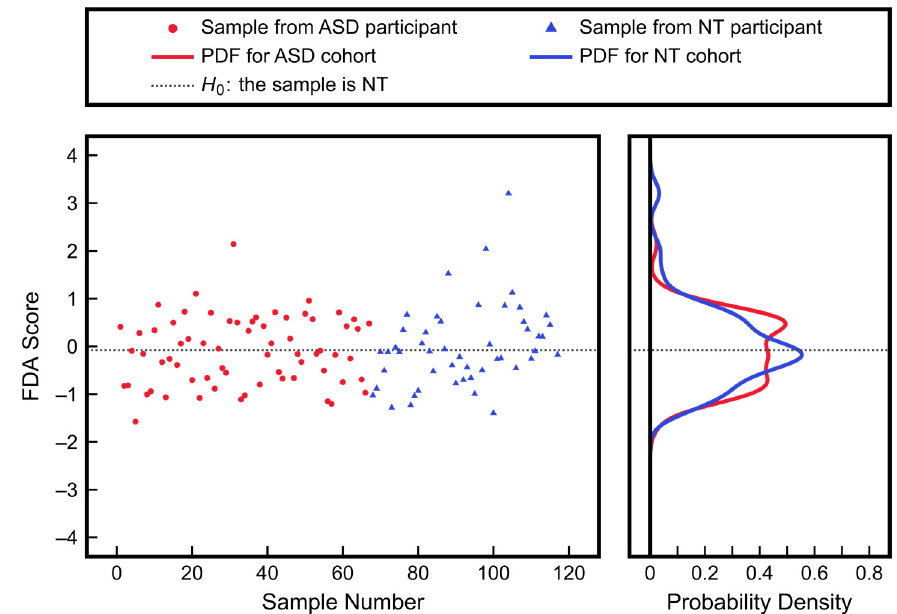
Figure 6. Results of classification using linear FDA with three urine toxic metal measurements (aluminum, cesium, tungsten) as inputs. FDA scores were from leave-one-out cross-validation and the PDFs were obtained by fitting to the scores. The Type I and Type II errors are both 50%.